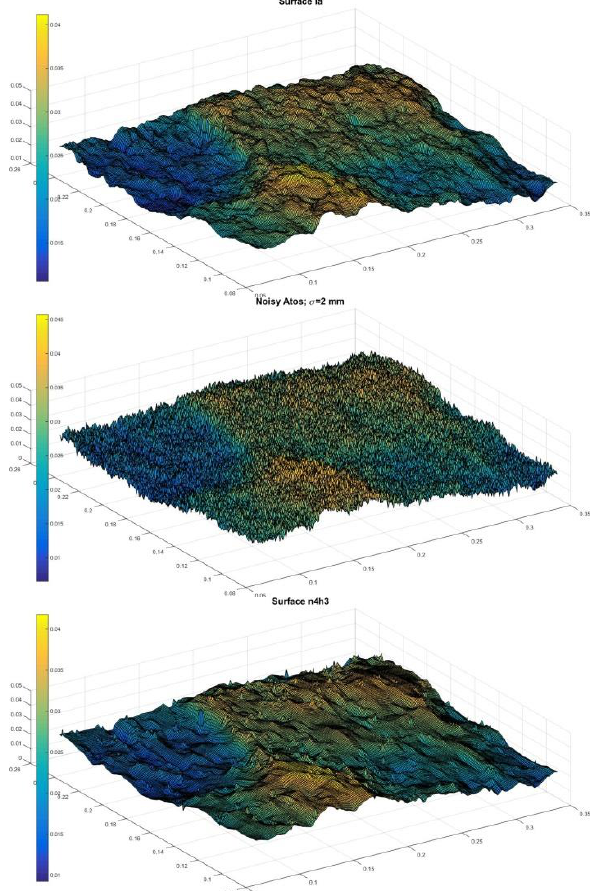
Figure 9. Visual comparison of 1 mm grid surfaces: original ATOS (top), noisy surface with 2 mm added noise (middle) and same surface denoised by DWT, penalised low hard thresholding